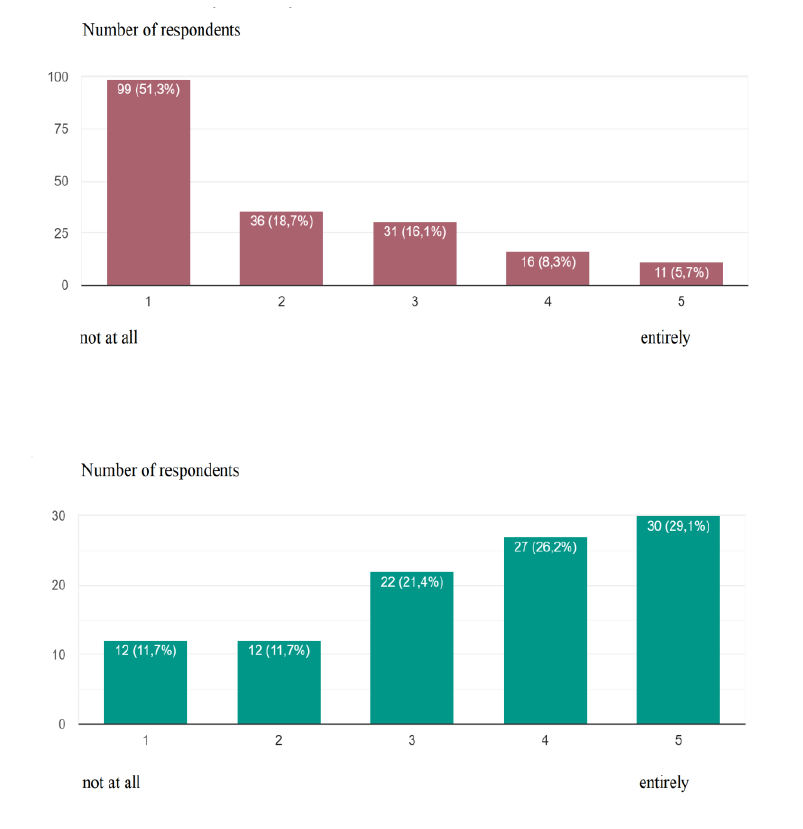
Fig. 3. Do you support a compulsory natural science subject at final